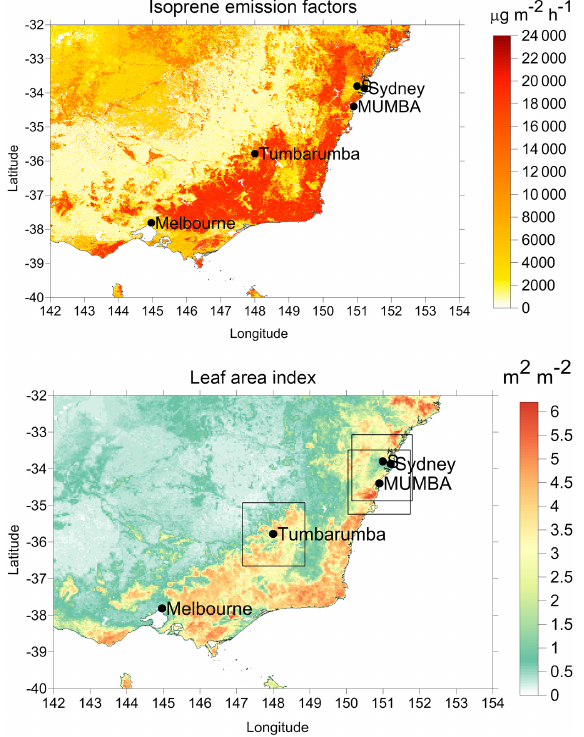
Figure 1. Southeast Australia at 1km resolution, showing (top) isoprene from the MEGAN global emission factor map and (bot- tom) LAI in January, with the boundaries of the inner model do- mains marked. Major cities and the field campaign locations are also shown. The Sydney field campaigns were located west of the Sydney